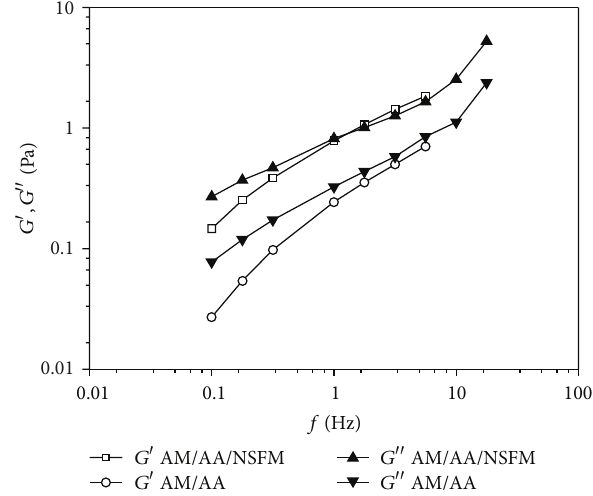
Figure 8: Viscoelasticity of AM/AA and AM/AA/NSFM at 65 ∘ C. The copolymers solutions (0.2 wt%) were prepared with distilled water.